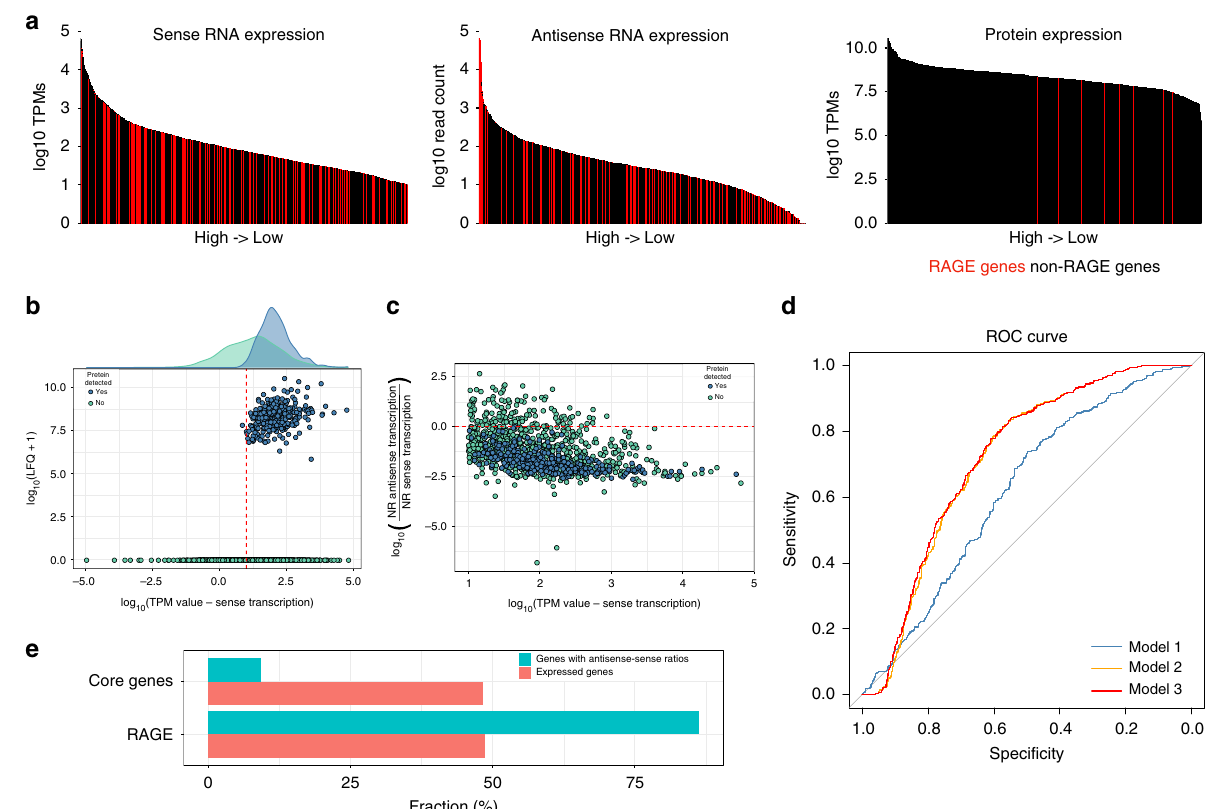
Fig. 3 Antisense transcription in Ot. a Sense RNA expression, antisense RNA expression, and protein expression over genes, ranked from high to low; RAGE (rickettsial-ampli fi ed genetic element) genes are marked in red. b Plot showing the relationship between protein expression, de fi ned by LFQs (label- free quantitations), and transcript expression, de fi ned by TPMs (transcripts per million). Genes cluster into two groups based on their protein expression. The red line indicates the threshold for expressed genes (TPM value equal to 10). c Sense transcription and the ratio of reads assigned to the antisense and sense strands, showing classi fi cation based on proteomics detection. The red line indicates the sense-antisense ratio (1.06) above which translation was not detected by mass spectrometry. d ROC (receiver operating characteristic) curves evaluating the performance of logistic regression models to predict protein expression from RNA-seq read counts. Model 1 strictly uses sense expression, model 2 the antisense – sense ratio, and model 3 uses both. Incorporating antisense expression clearly improves model performance. e Fraction of core genes and RAGE genes in the set of genes with high antisense – sense ratios, compared to all expressed genes.